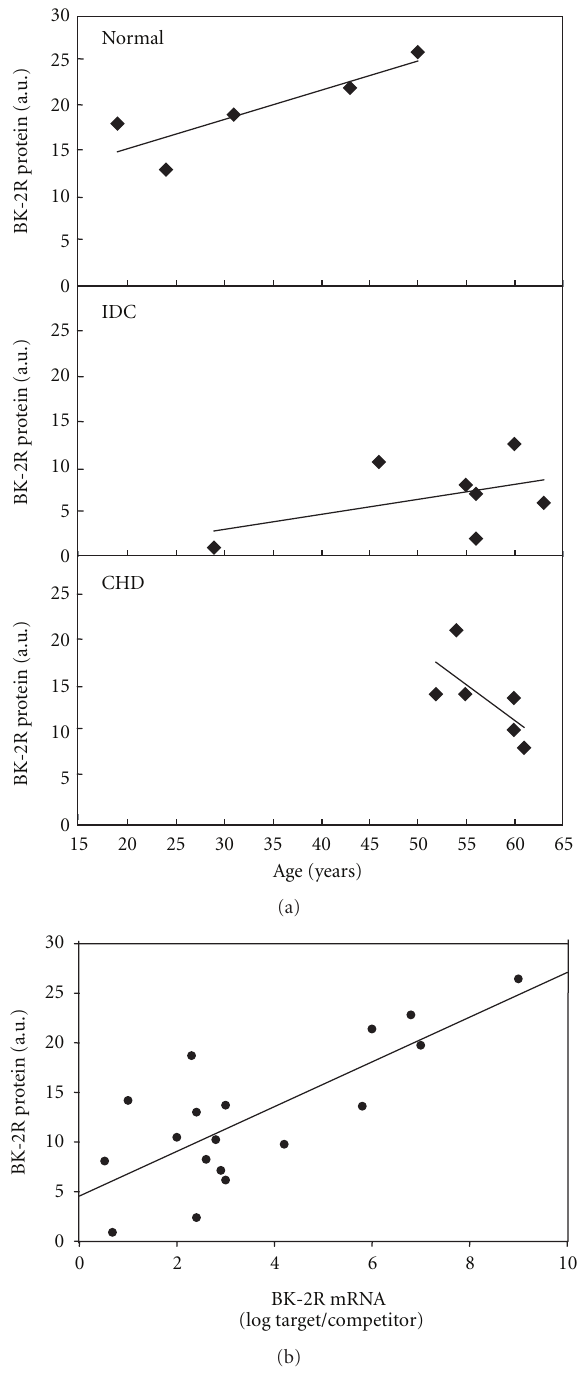
Figure 2: (a) BK-2R protein levels in normal and failing hearts show a linear trend (not significant) when plotted against age. (b) BK-2R mRNA expression levels plotted against BK-2R protein levels show a positive linear correlation ( R = 0 . 761, P < 0 . 001), suggesting that BK-2R expression may be regulated on the transcriptional level.